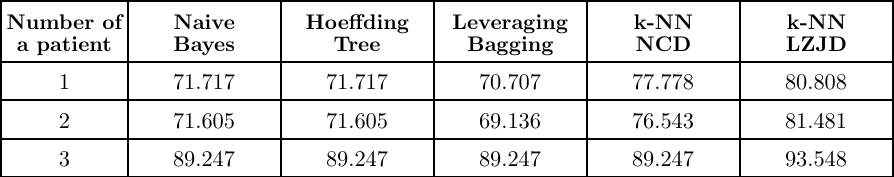
Table 4. Classification results obtained for three patients with the use of other popular stream